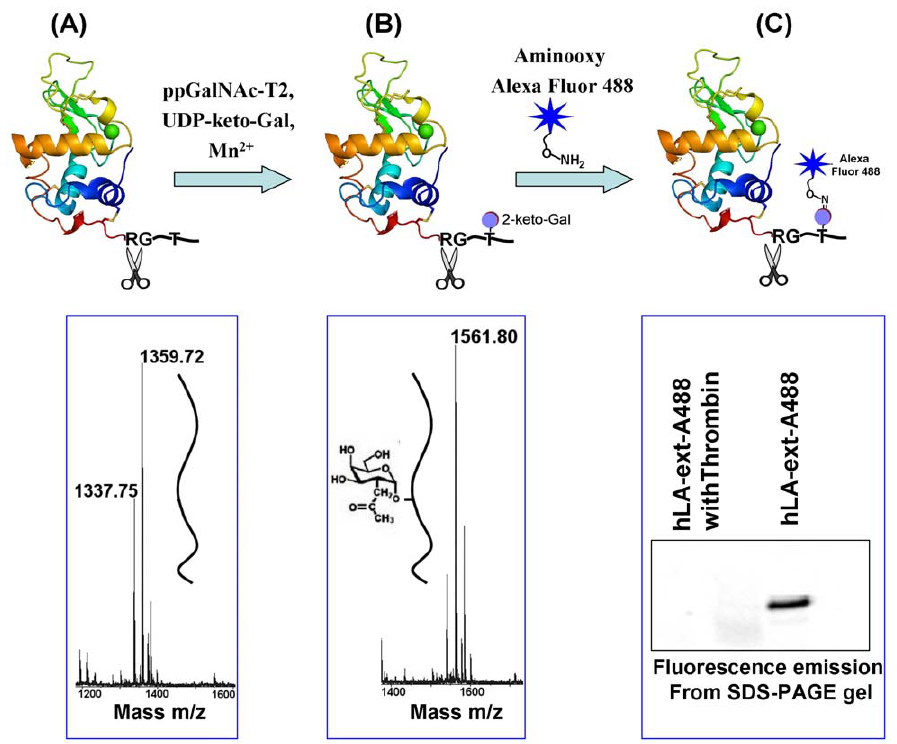
Figure 4. Site-specific labeling with aminooxy-Alexa Fluor 488 of hLA-ext. The hLA-ext protein (A) is glycosylated by the ppGalNAc-T2 enzyme in the presence of Mn 2 + and UDP-C2-keto-galactose. The lower panel shows the MALDI-TOF analysis of the C-terminal extension peptide released upon thrombin cleavage. (B) The glycosylated hLA-ext protein with a single C2-keto-Gal molecule (blue circle) is conjugated with the aminooxy-Alexa Fluor 488 molecule. The lower panel shows the MALDI-TOF spectrum of the glycosylated C-terminal extension peptide released after thrombin treatment of the glycosylated hLA-ext protein. The increased molecular weight of 201 Da corresponds to a single C2-keto-gal molecule. Since the Alexa Fluor 488 conjugated C-terminal peptide released from the Alexa Fluor 488 conjugated hLA-ext protein could not be observed on a MALDI-TOF spectrum, the protein with and without thrombin treatment was analyzed on a SDS-PAGE gel (C) for the fluorescence emission detection (lower panel). Fluorescence emission from the protein band is only observed when the protein was not treated with the thrombin, suggesting that the Alexa Fluor 488 molecule is conjugated to the C-terminal extension peptide.